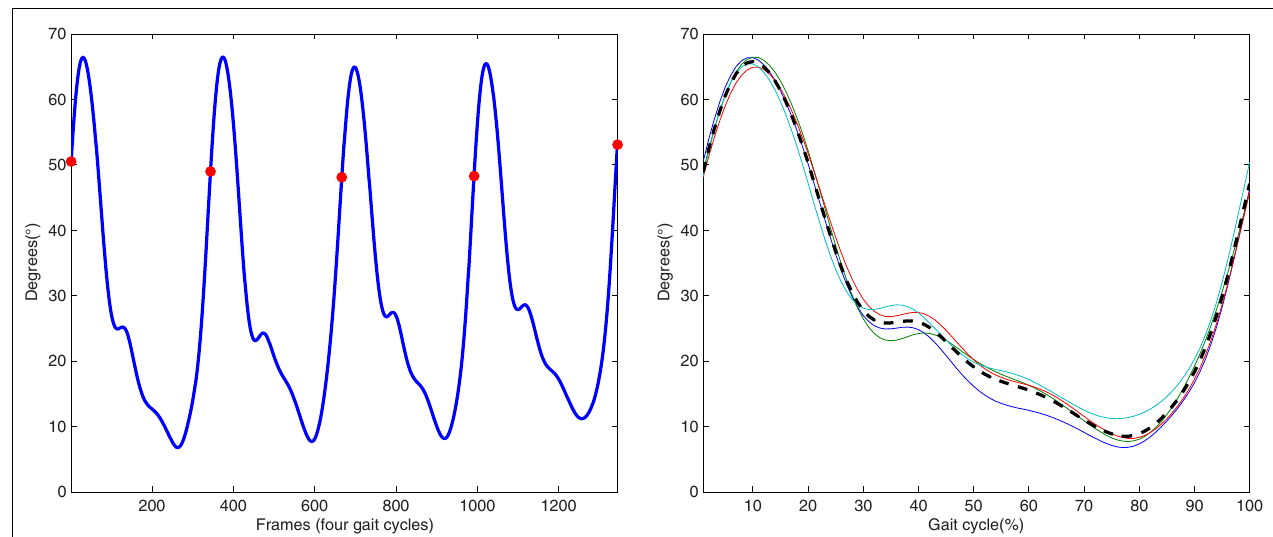
FIGURE 2 | On the left is the original left knee angle trajectory (four complete gait cycles), while on the right an averaged and normalized in time left knee trajectory is derived (dotted line) from the trajectories of the four consecutive gait cycles.